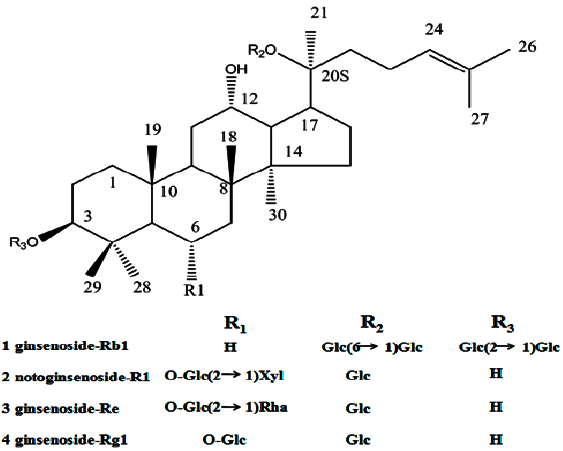
Figure 1. Structure of dammarane saponins 1 – 4 from panax notoginseng saponins.